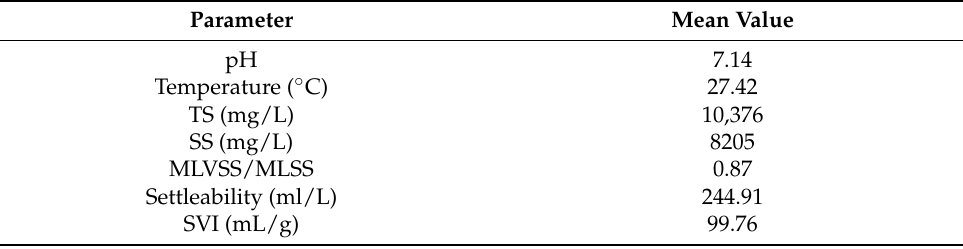
Table 1. STP’s activated sludge